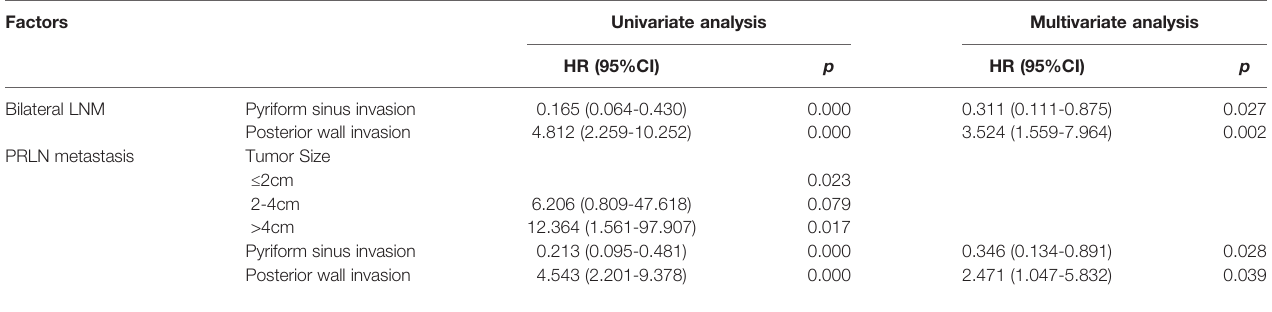
TABLE 3 | The risk factors for bilateral LNM and PRLN metastasis.